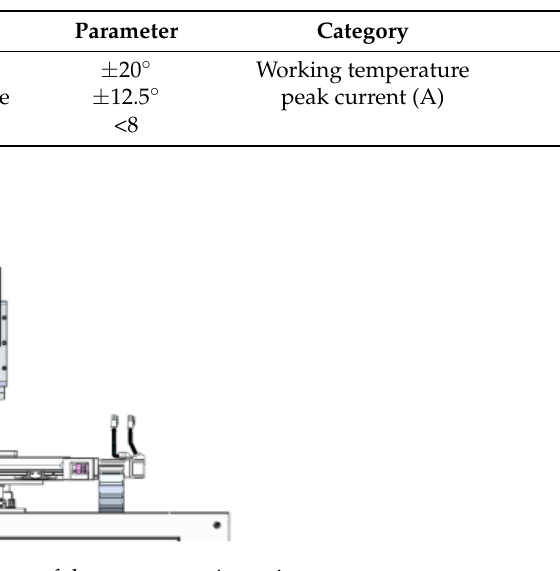
Figure 4. Schematic diagram of the system motion axis structure.